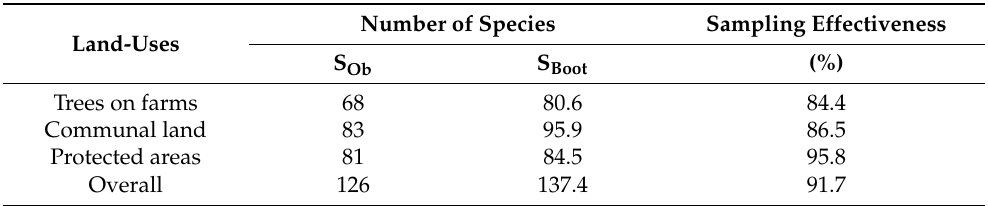
Table 1. Actual and estimated tree species richness between different land-uses with sampling effectiveness estimates.